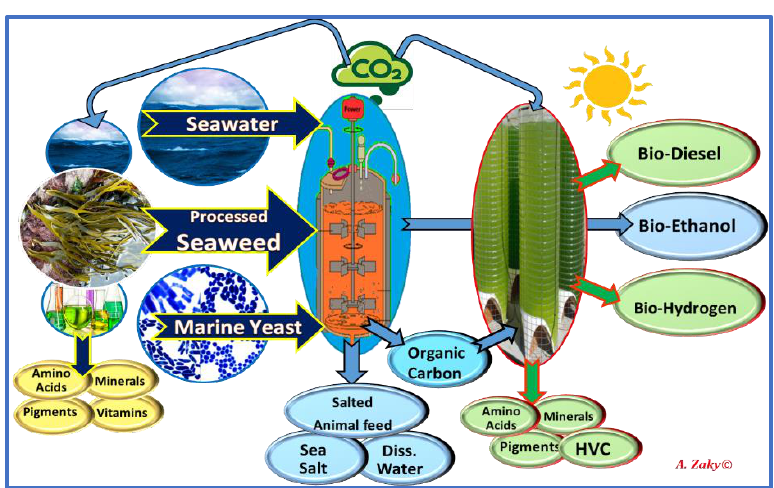
Figure 6. Coastal integrated marine biorefinery (CIMB) system (Route 2).